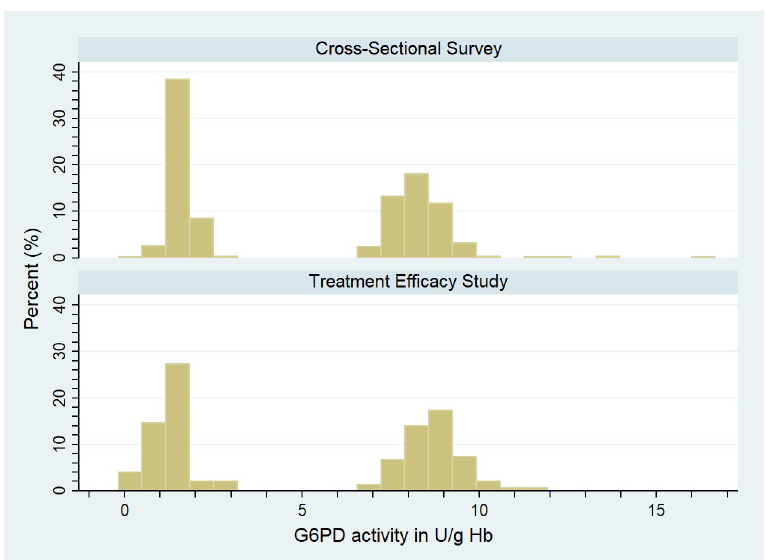
Fig 1. Distribution of G6PD activity in normal and deficient controls by study. G6PD, glucose-6-phosphate dehydrogenase.